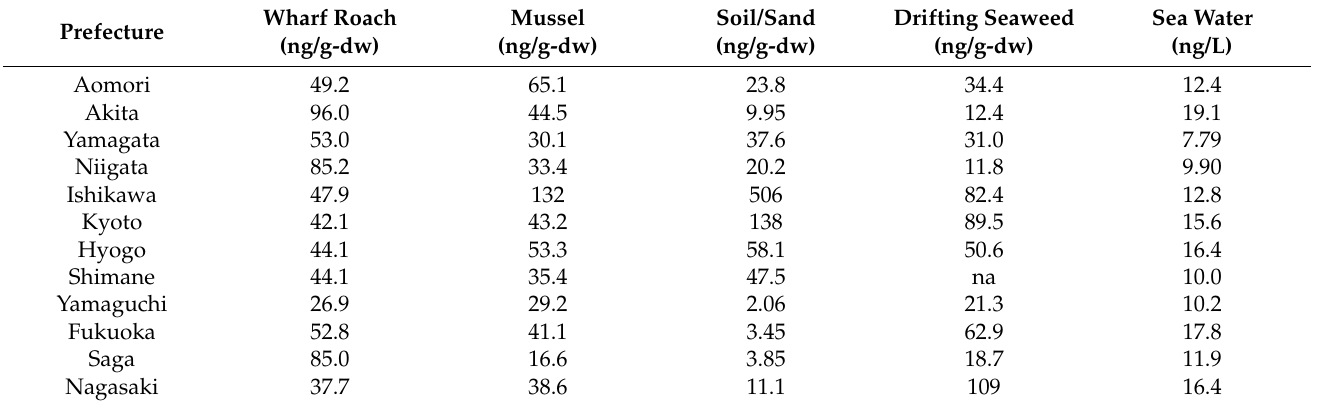
Table 2. Total concentration of 15 PAHs in samples from 12 sampling sites (ng/g-dw or